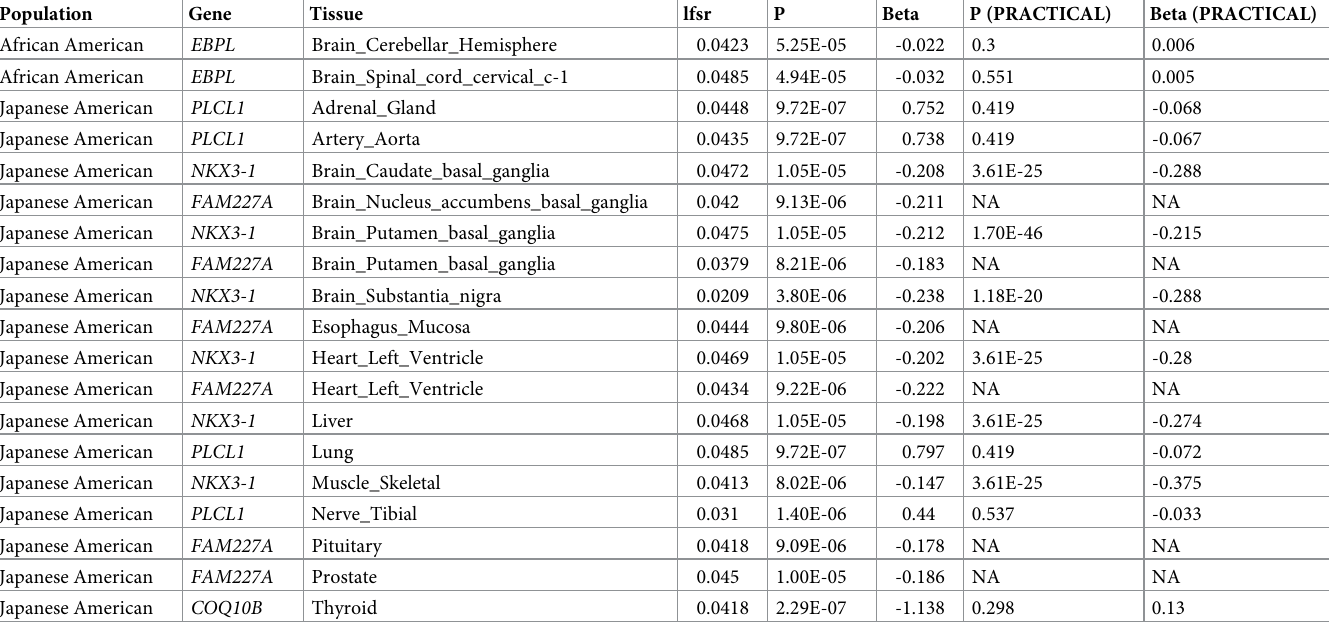
Table 2. PrediXcan significant genes significant ( lfsr < 0.05) gene-tissue pairs from PrediXcan analysis. lfsr represents the local false sign rate as calculated using adap- tive shrinkage [32]. P(PRACTICAL) represents P-value for the gene-tissue pair in the S-PrediXcan analysis of the PRACTICAL summary statistics. Beta(PRACTICAL) represents the effect direction and size predicted from S-PrediXcan. “NA” means that the gene was not tested in the PRACTICAL summary statistics.